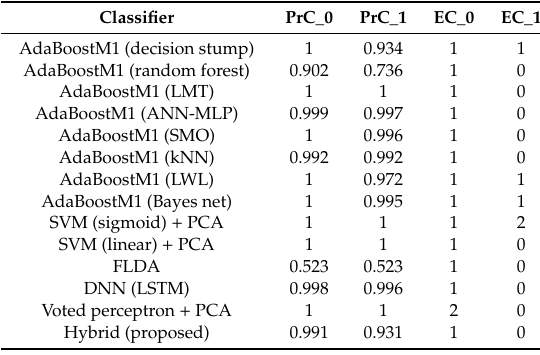
Table 4. Evaluating predictions using unseen data. Two individual test sets were considered: 10 samples were taken from healthy test subjects and 10 samples were taken from sick test subjects. The average PrC_0 from 10 samples (healthy test set, target class = 0), the average PrC_1 from 10 samples (sick test set, target class = 1), the EC_0 (healthy test set, target class = 0), and EC_1 (sick test set, target class = 1) were